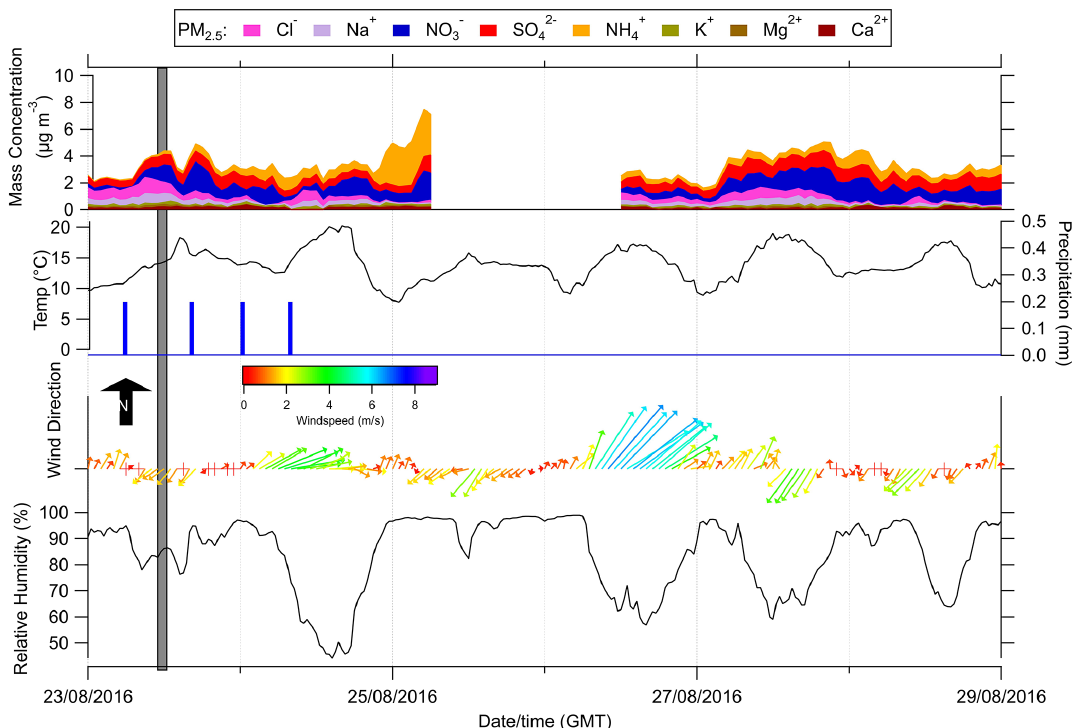
Figure 2. Summary of the meteorology and the inorganic composition of water-soluble PM 2 . 5 at Easter Bush during the intercomparison campaign from 23 to 29 August 2016. The grey shaded line is the period where urea was applied to fields. Blue bars are precipitation, and the black line is the